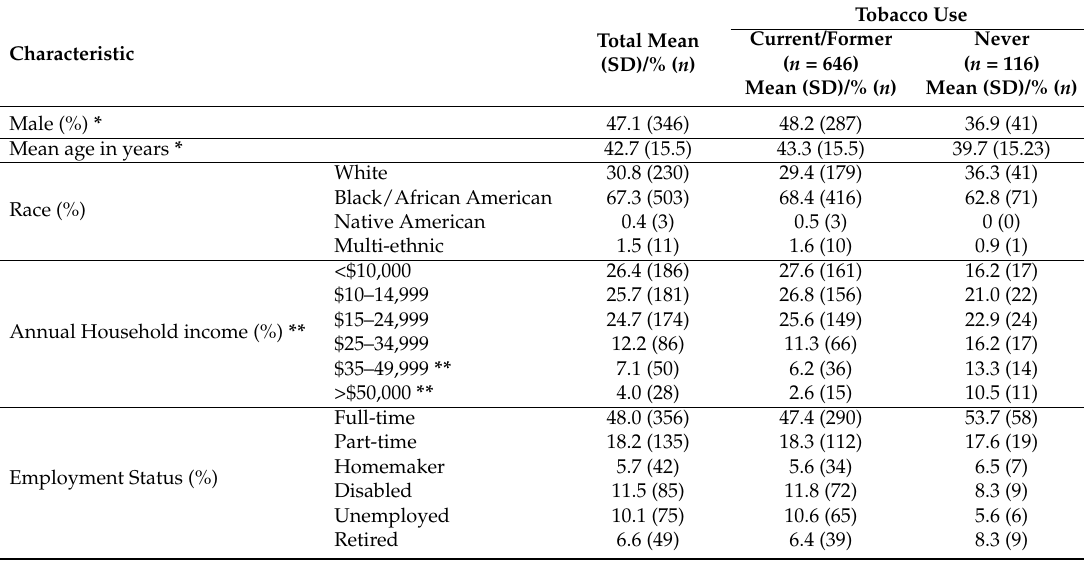
Table 1. Demographic characteristics of